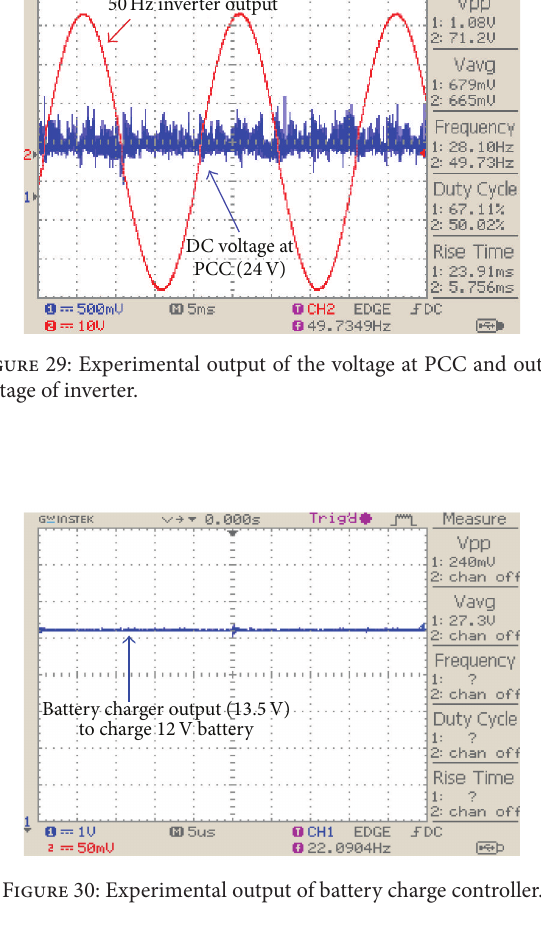
Table 3: Specification of solar panel.